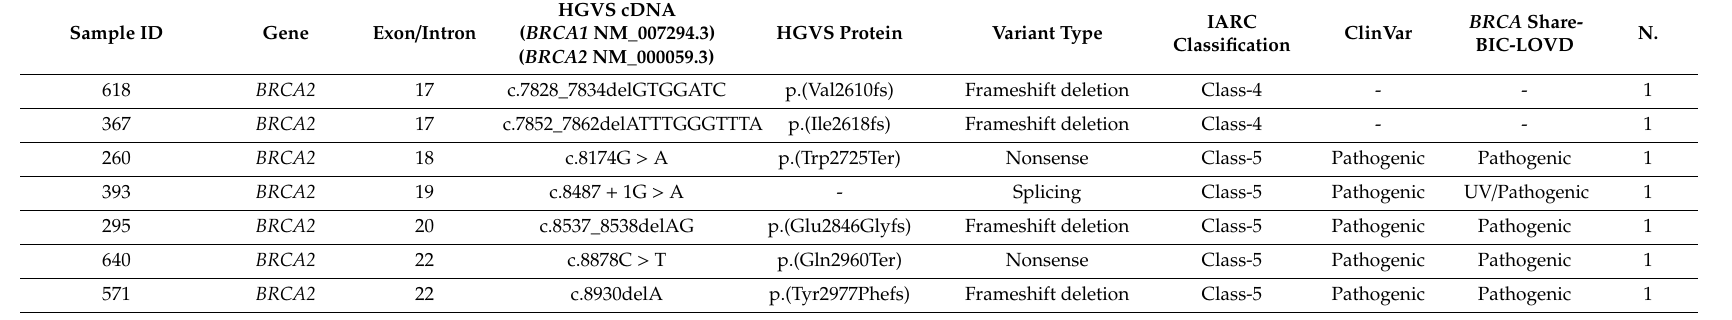
Table 2 (B) List of BRCA1 and BRCA2 Variant of Uncertain Significance (VUS) Variants Detected in 33 Central Italian